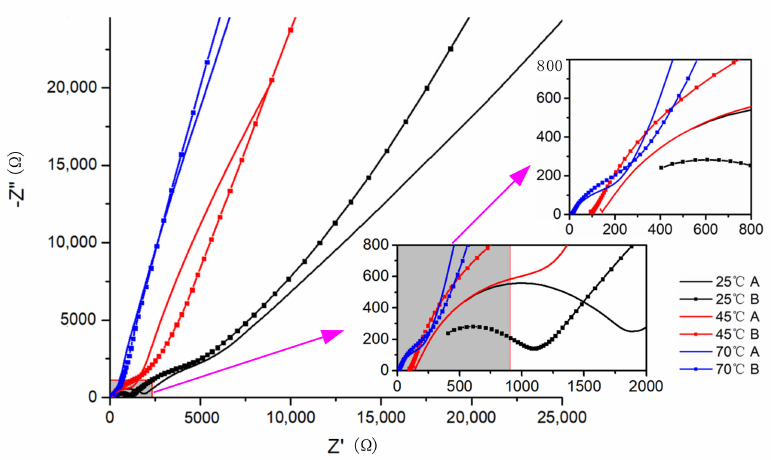
Figure 6. Alternating current (AC) impedance tests at di ff erent temperatures, where Group A is non-ultrasonic treated and Group B is ultrasonic treated.